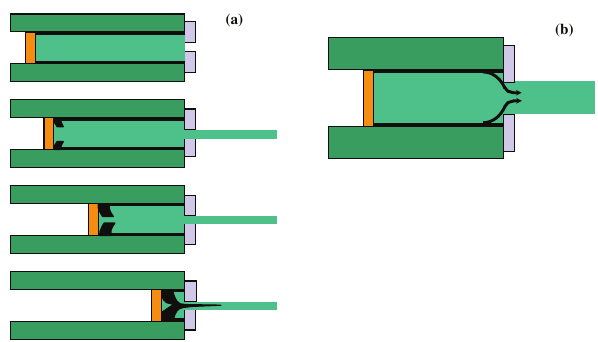
Figure 2. Mechanisms of billet skin entrapment during extrusion. (a) Flow of billet skin via back end and (b) flow of billet skin via front